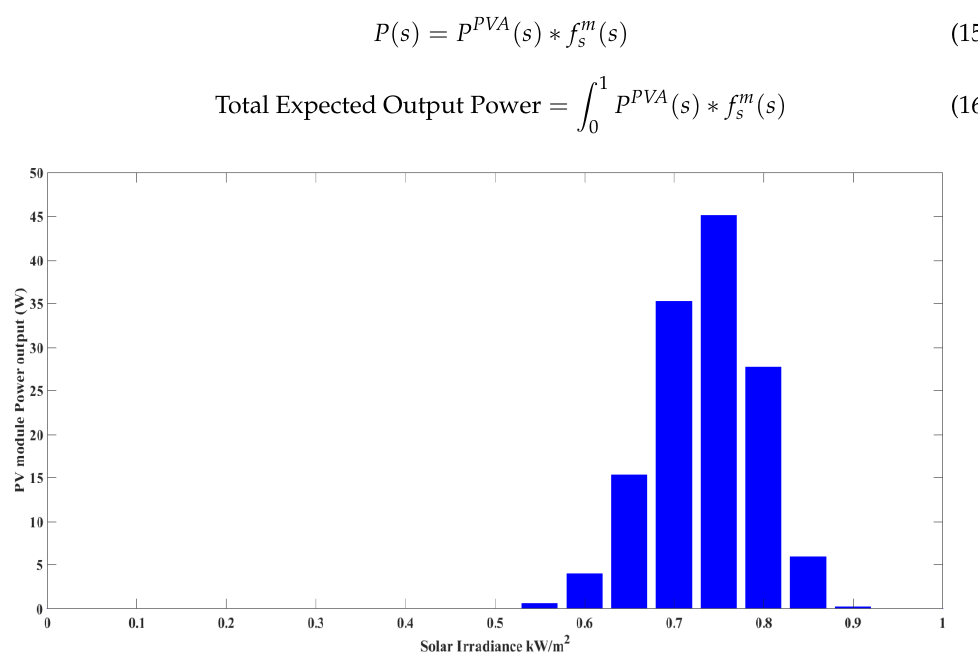
Figure 2. Expected Output Power from Solar